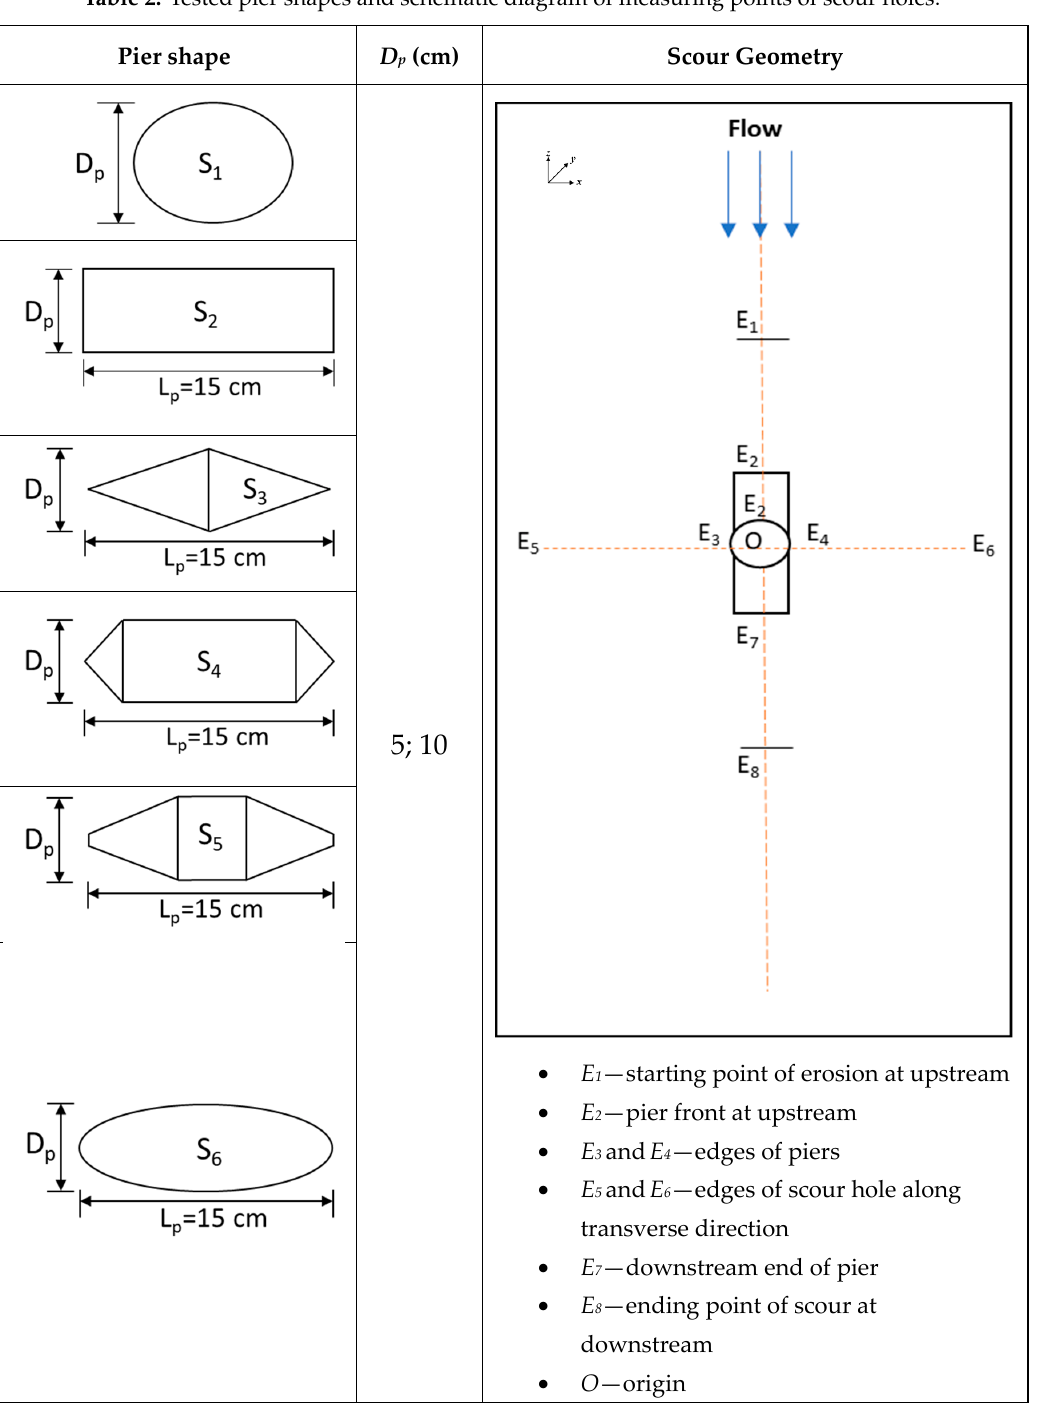
Table 2. Tested pier shapes and schematic diagram of measuring points of scour holes.